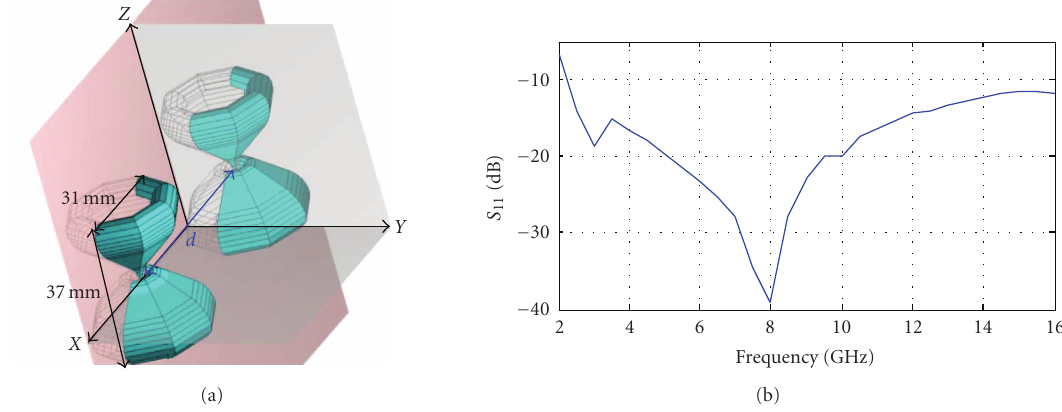
Figure 4: (a) ENSTA bicone antennas and (b) ENSTA bicone return loss.